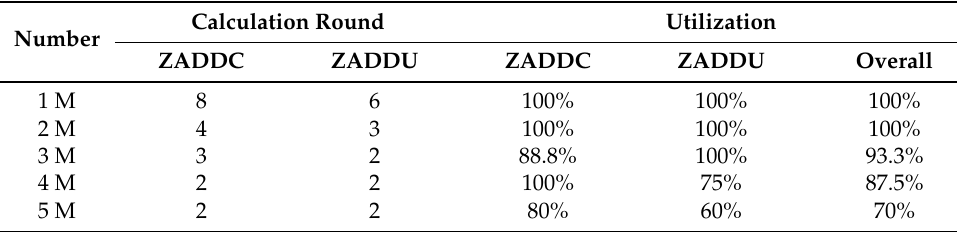
Table 2. Modular multiplier number comparison.